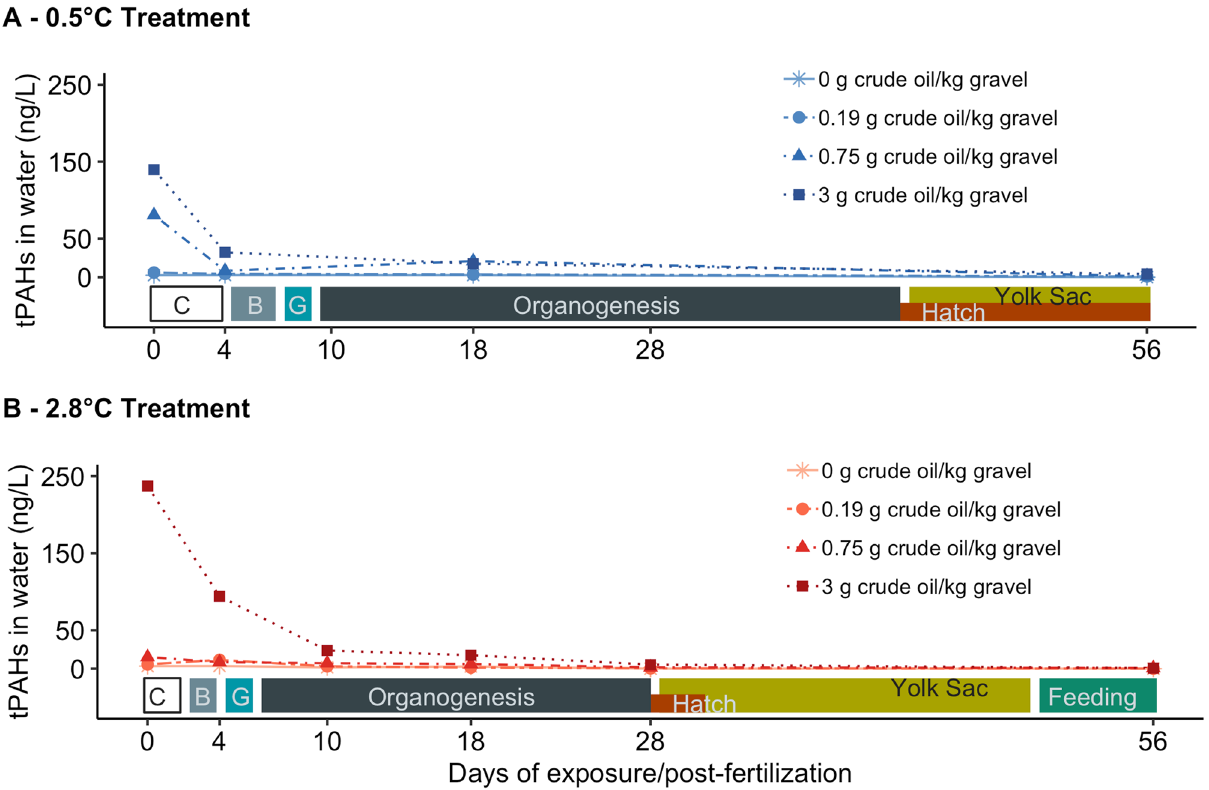
Figure 1. The concentration of tPAHs (ng/L) over time in ( A ) the cold, 0.5 °C temperature group and ( B ) the warm, 2.8 °C temperature group. Different concentrations of crude oil and gravel are distinguished by color, shape and line type. The best linear model lm(tPAH ~ Time + factor(Temperature) + factor(Oil Treatment) reported significant effects of time (F-value = 6.09, p-value = 0.019), and oil treatment (F-value = 4.5034, p-value = 0.009), but not temperature (F-value = 0.0211, p-value = 0.885). The developmental timeline of embryos and larvae in each temperature group are displayed in each panel. Early embryogenesis is divided into cleavage stage (C), blastulation (B), and gastrulation (G).